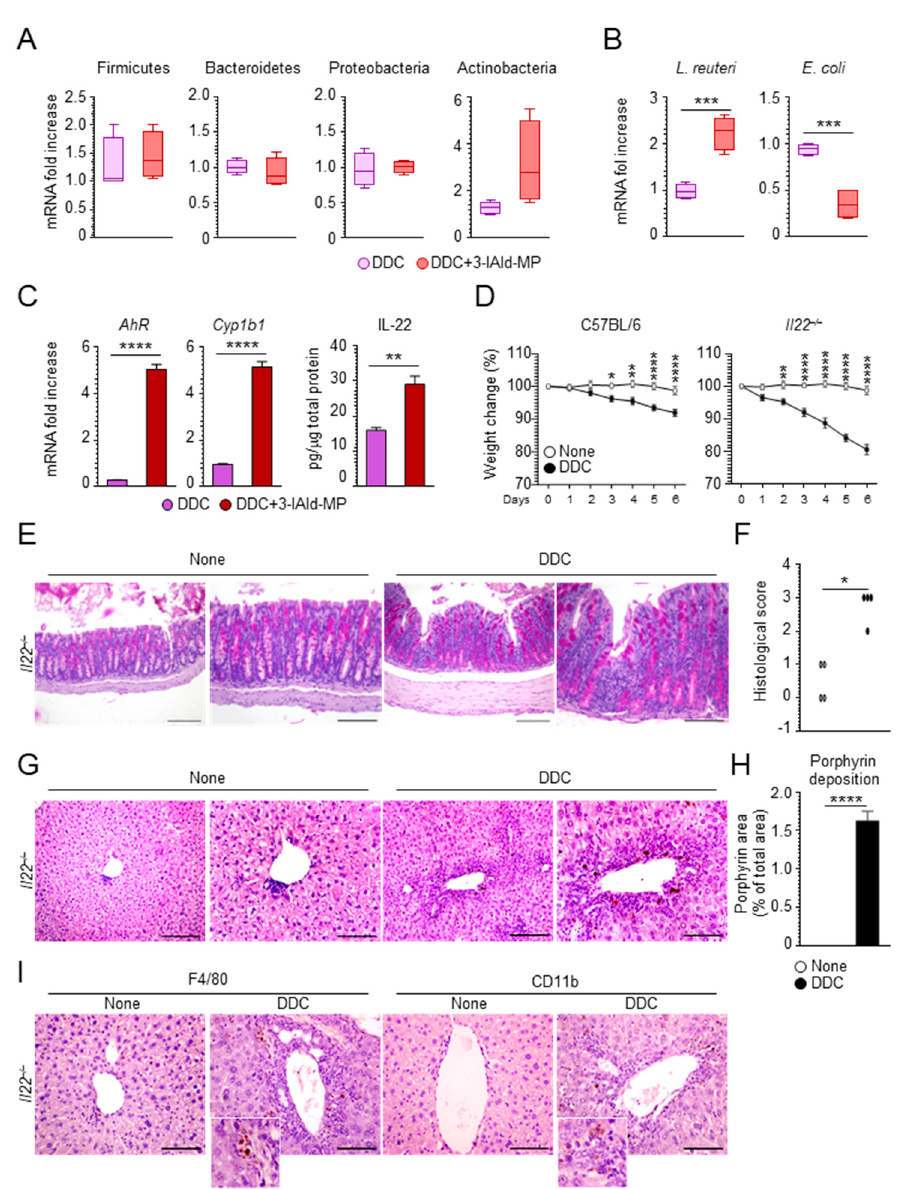
Figure 5. 3-IAld-MP protects from sclerosing cholangitis through the microbiota-AhR-IL-22 axis. C57BL/6 mice were fed a 0.1% DDC-containing diet and subjected to a recovery time of 14 days. The mice were treated intragastrically with 3-IAld-MP every other day throughout the experiment and evaluated for ( A ) bacterial phyla expression, ( B ) L. reuteri and E. coli in fecal samples, ( C ) AhR and Cyp1b1 expression by RT-PCR, and IL-22 production by ELISA in colon homogenates. Il22 –/– mice were fed with a 0.1% DDC-containing diet for 6 days and evaluated for ( D ) % weight change, ( E ) colon histology by PAS staining, ( F ) histological score, ( G ) liver histology by H&E, ( H ) porphyrin deposition, and (I) CD11b + and F4/80 + cells by immunohistochemistry. Photographs were taken with a high-resolution microscope (Olympus BX51), 20× and 40× magnification (scale bars, 200 μ m and 100 μ m). The data are presented as the mean ± SEM and are representative of three experiments ( n = 4 mice/group). * p < 0.05, ** p < 0.01, *** p < 0.001, **** p < 0.0001, treated vs untreated (none) mice or DDC vs DDC + 3-IAld-MP. One-way ANOVA, Bonferroni post-test, two-tailed Student’s t-test, ( F ) Kruskal–Wallis test.